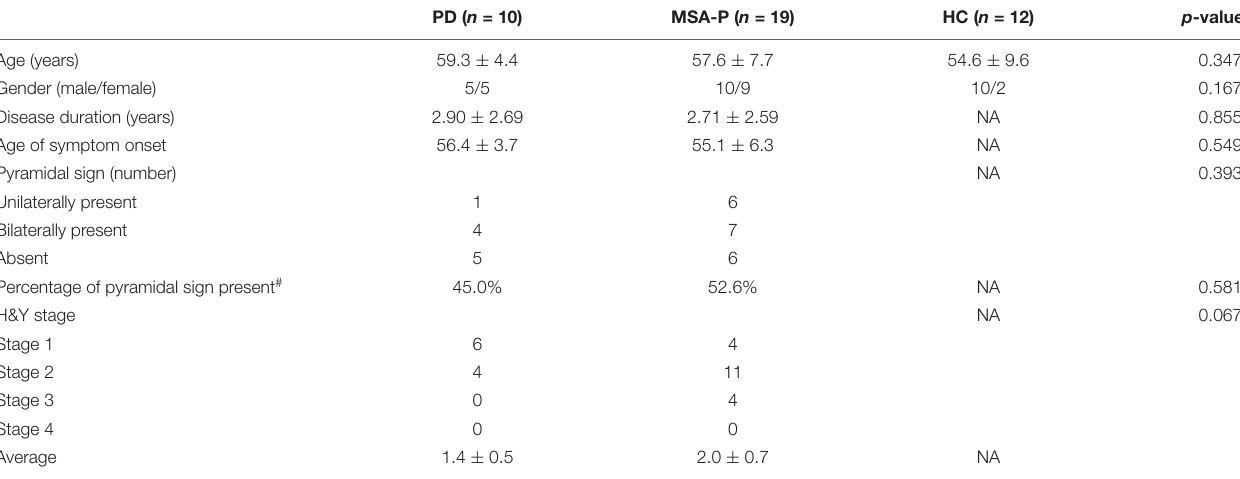
TABLE 1 | Demographic and clinical characters of patients and healthy controls.